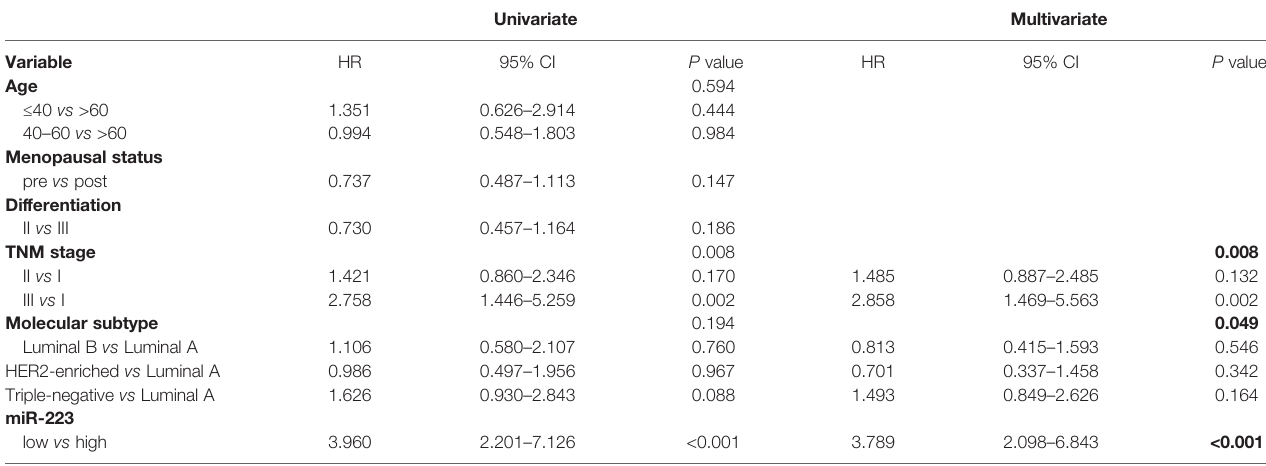
CI, con fi dence interval; HR, hazard ratio. The covariates in the Cox model were all categorical variables, and the adjusted p value and HR were derived from the model.